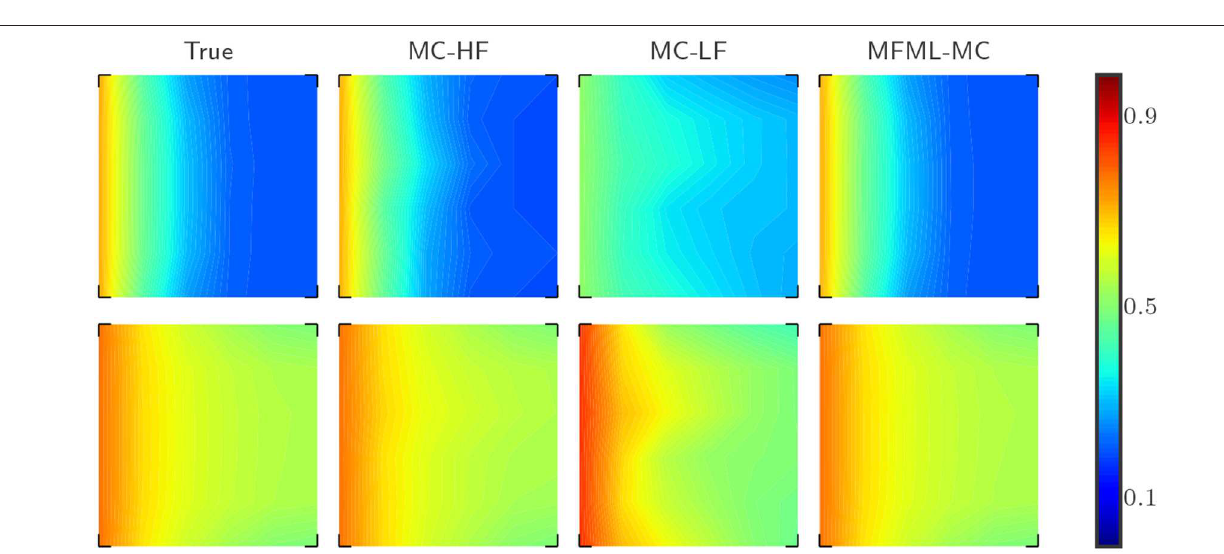
6 spatial grid) for a fixed computational budget p × 0.3 PVI. (Bottom Row) Estimation of E [ u t ] at time t =